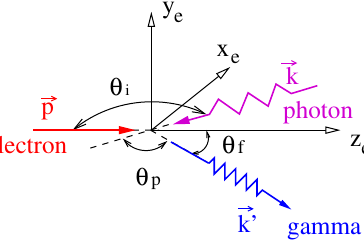
FIG. 1. Geometry of Compton scattering of an electron and a Þ in which the ; y ; z photon in a lab-frame coordinate system ð x e e e direction. The incident photon is electron is incident along the z e and propagating along the direction given by the polar angle (cid:2) i . The collision occurs at the origin of the azimuthal angle (cid:3) FIG. 2. The relation between the scattered photon energy (in i coordinate system. After the scattering, the scattered photon MeV) and scattering angle in an observation plane, which is 60 and propagates in the direction given by the polar angle (cid:2) meters downstream from the collision point. The scattered f azimuthal angle (cid:3) . (cid:2) is the angle between the momenta of photons are produced by 800 nm photons scattering with f p incident and scattered photons, ~k and ~k 0 . The electron after 500 MeV electrons. Each concentric circle is an equi-energy scattering is not shown in the figure. contour curve of the energy distribution of scattered